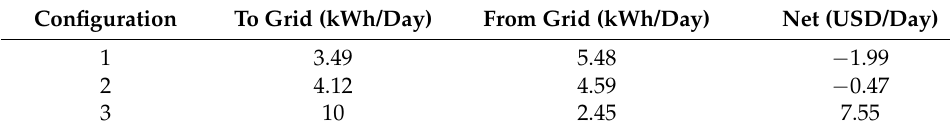
Table 3. Daily energy cost (the electricity tariff is considered fixed).